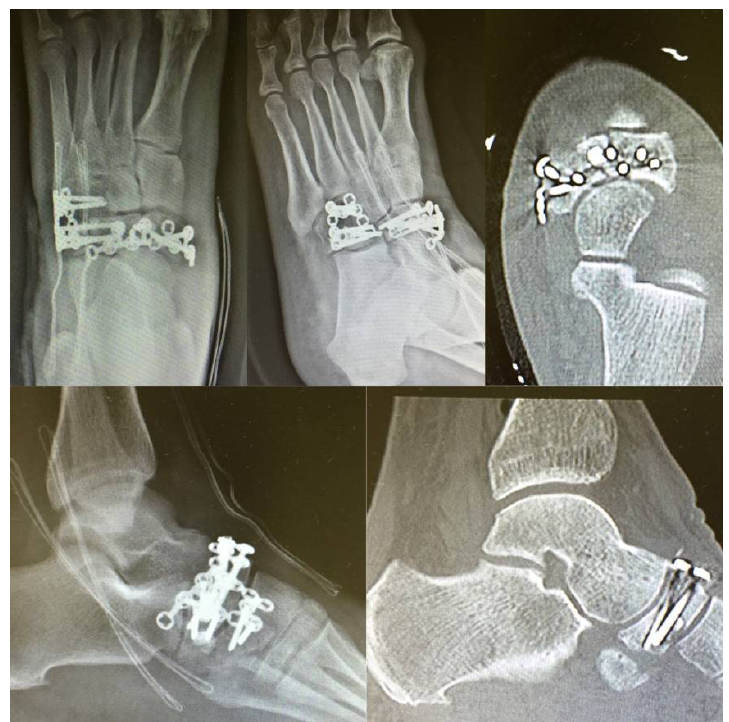
Figure 4. Postoperative X-rays imaging and CT scan.